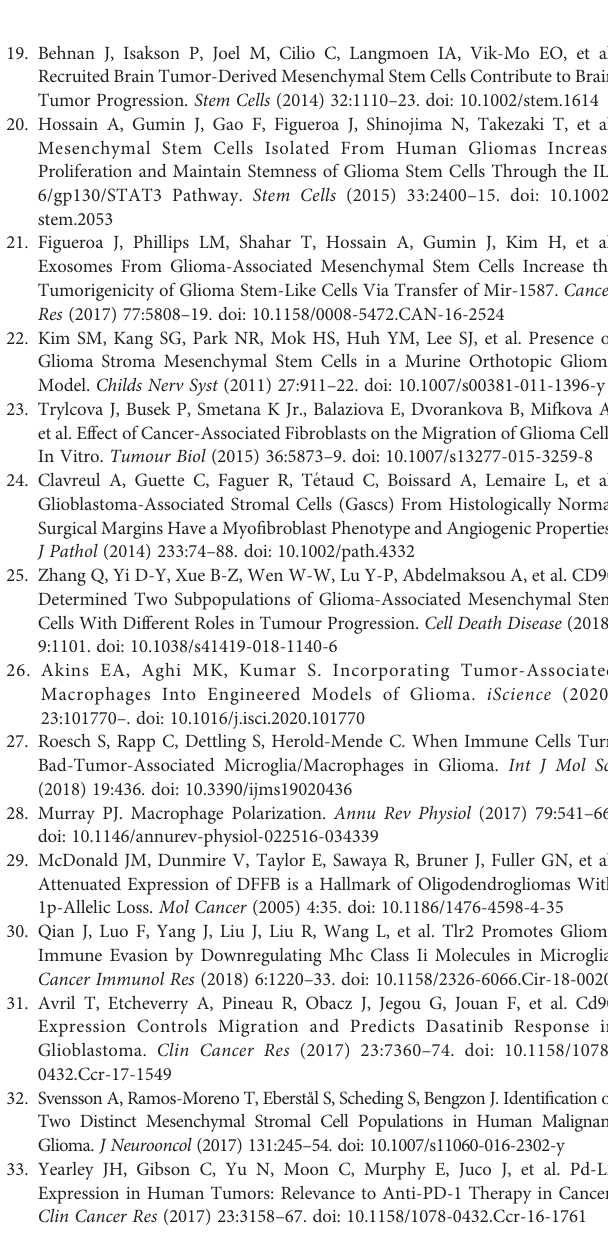
(E) Correlation of GASC and Predicted immunotherapy responses. (F – I) Bar chart